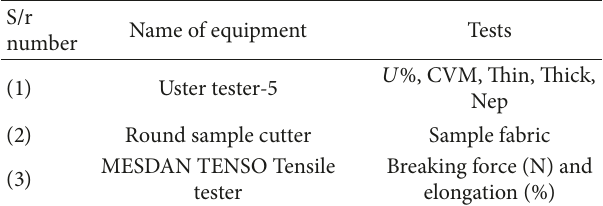
Table 4: Equipment and materials